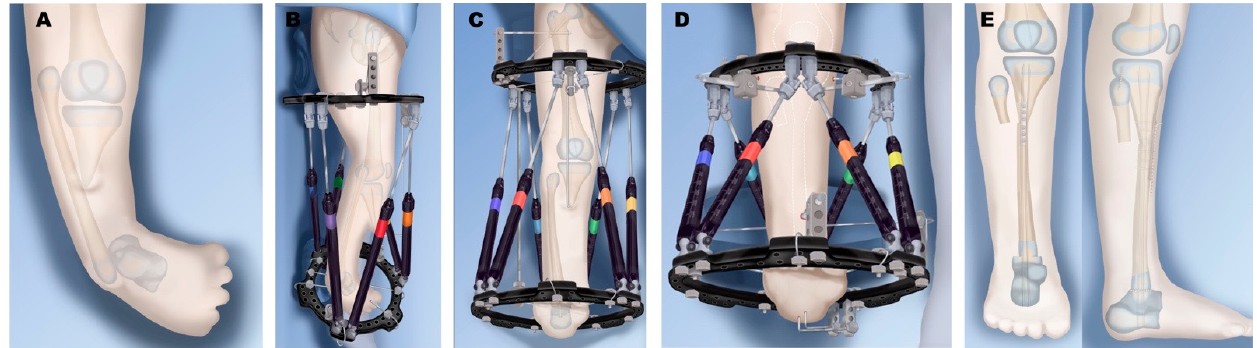
Figure 7. Treatment of Paley type 3B. ( A ) Distal tibia and fibula diastasis with skin cleft. Fibula is associated with talus and foot. ( B ) Application of external fixator for distraction and gradual correction. ( C ) Foot now in plantigrade position. ( D ) Excision and closure of skin cleft performed at time of diastasis stabilization and tibiotalar biologic arthroplasty as in type 3A.